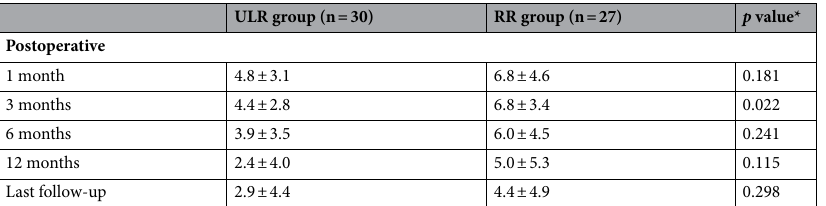
Table 3. Mean reduction in near-distance difference (PD) after the surgery. Mean ± standard deviation. PD prism dioptres, ULR group patients who underwent unilateral lateral rectus recession. RR group patients